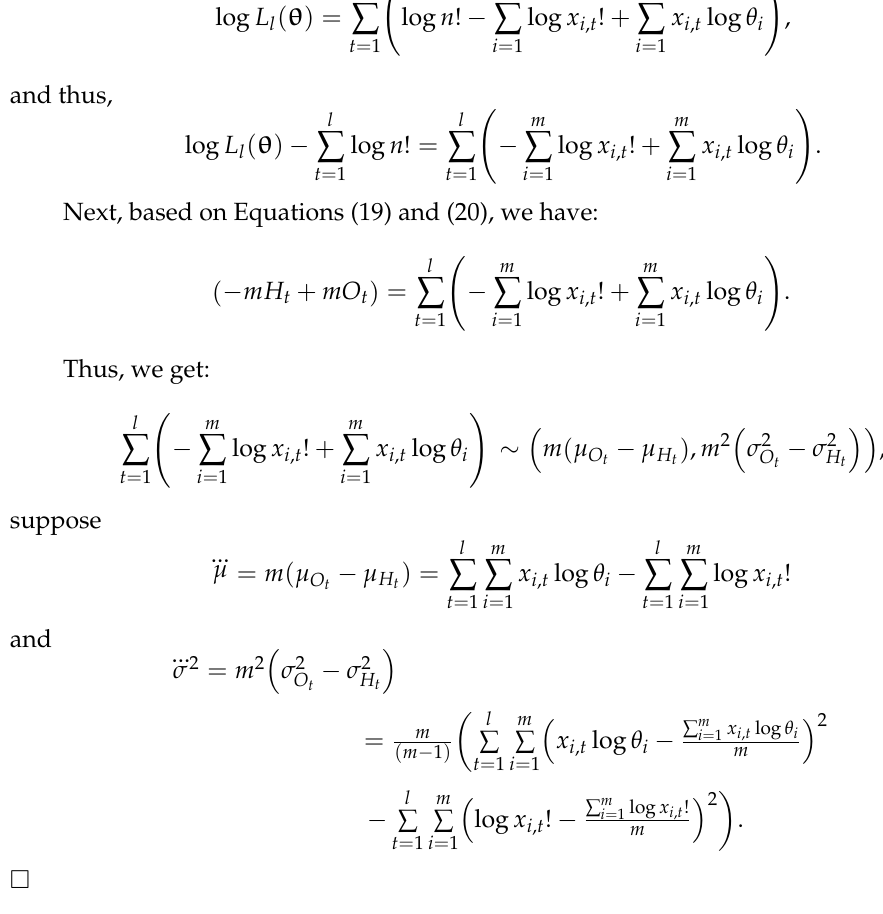
2000 times, are shown in Figure 5.